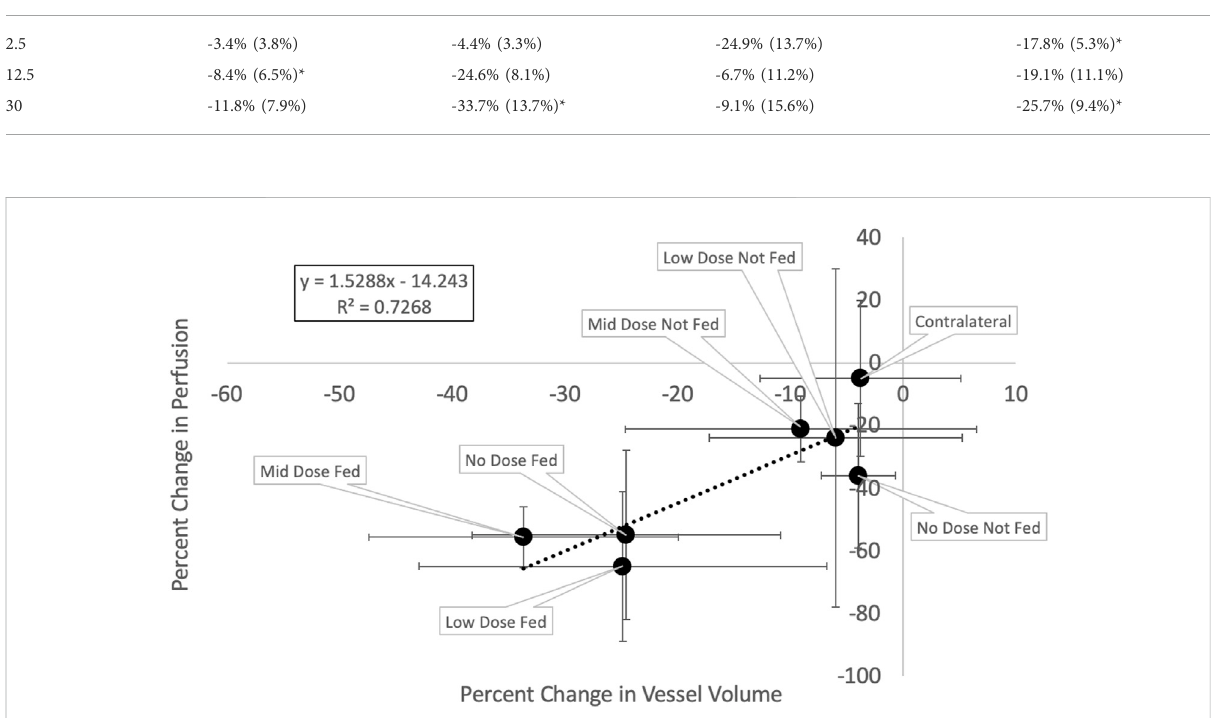
FIGURE 11 Change in vessel volume vs change in perfusion. Each point represents a different analysis contour and is the average of the fi ve swine subjects with error bars representing the standard deviations in each